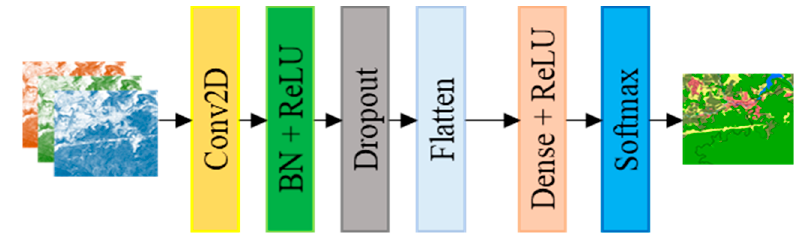
Figure 2. The architecture of CNN-1 used for feature extraction in the proposed ZSL framework.